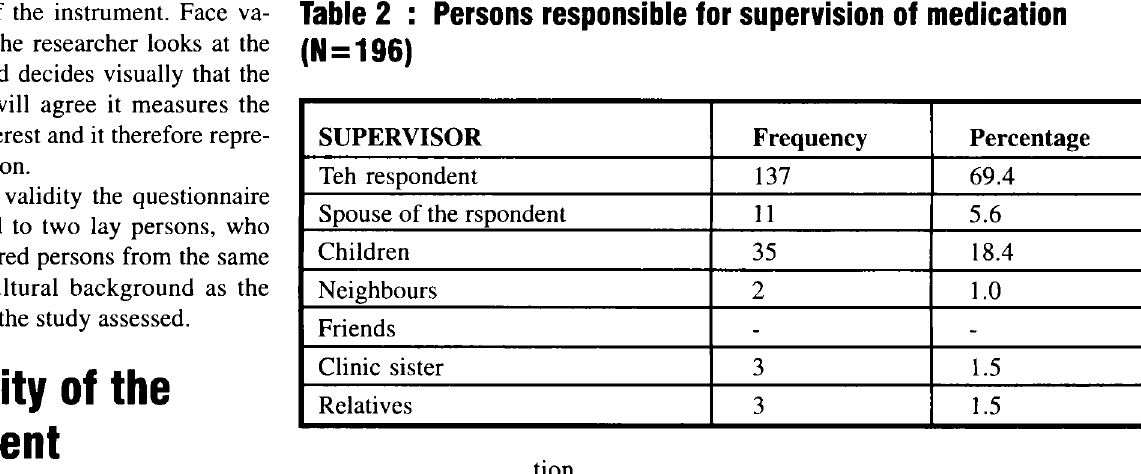
Table 2 : Persons responsible for supervision of medication